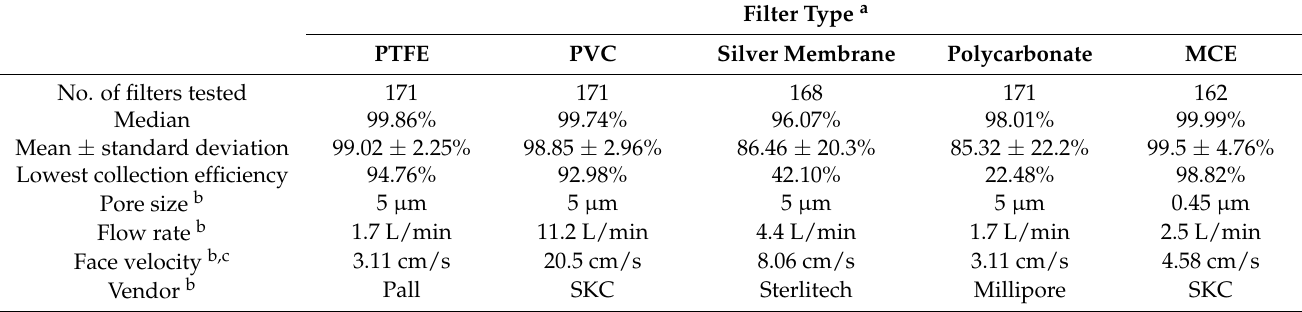
Figure 3. Average and standard deviation of collection efficiency of five types of 37 mm filters with 5 µ m pore size tested with a nanoparticle diameter range of 10–400 nm at 1.7 L/min. Aerosol measurements were conducted using three different filters for each filter type (n = 3). The two overlapping point symbols for MCE and PVC filters are denoted as solid circle and star symbols [107]. Reprinted by permission of Taylor & Francis Ltd. on behalf of the American Association for Aerosol Research. Table 3. Summary of collection efficiency on membrane and capillary pore filters over a range of pore sizes and flow rates